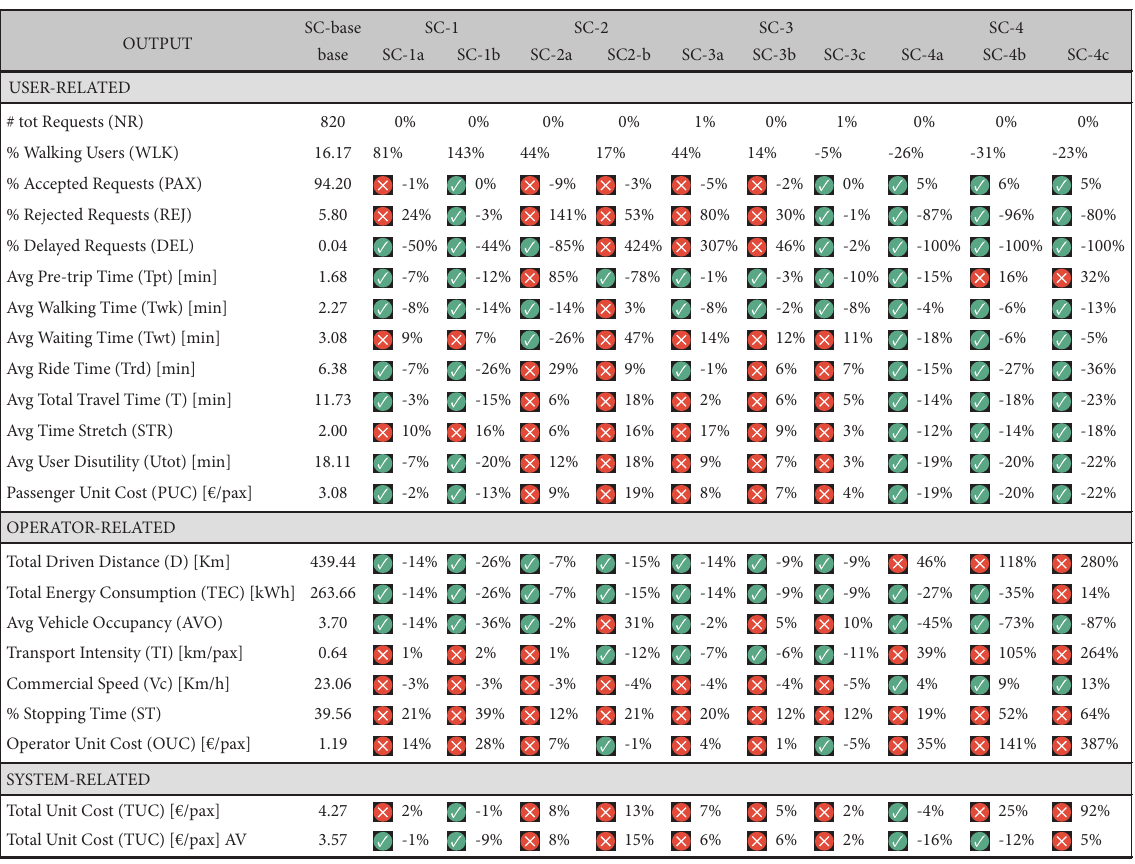
Figure 15: Summarizing table with DRF simulation outputs (for scenarios 1–4, percentage variations are reported with respect to